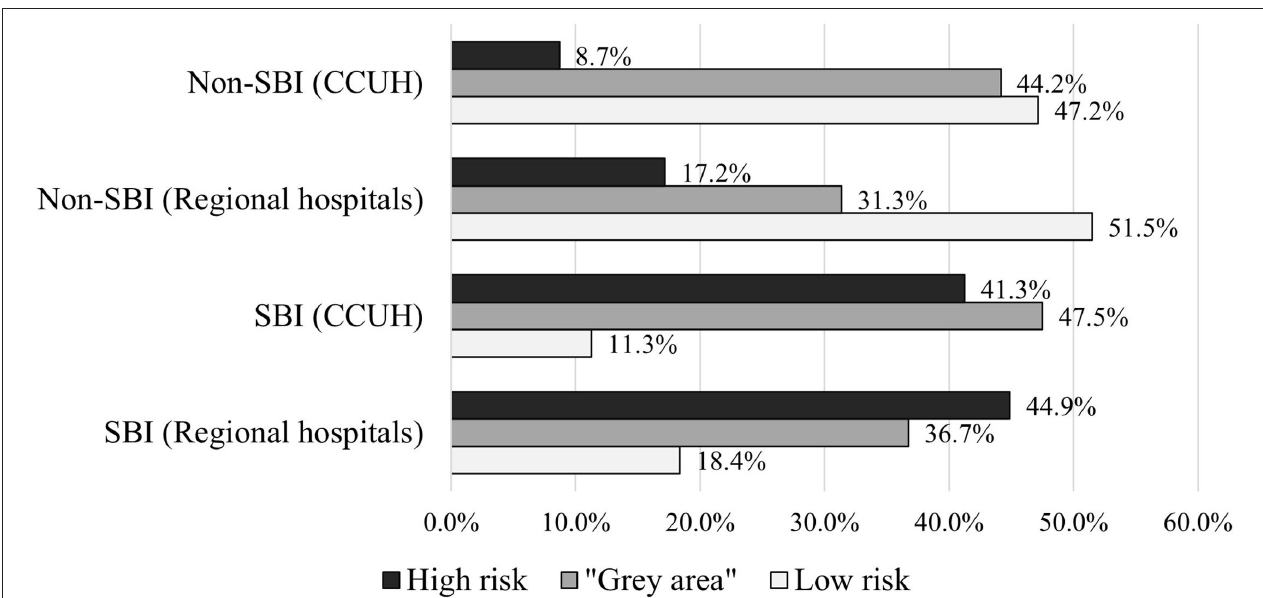
FIGURE 5 | Categorization of patients with and without serious bacterial infection (SBI) in derivation and validation cohorts according to scoring system based on CPM 2.